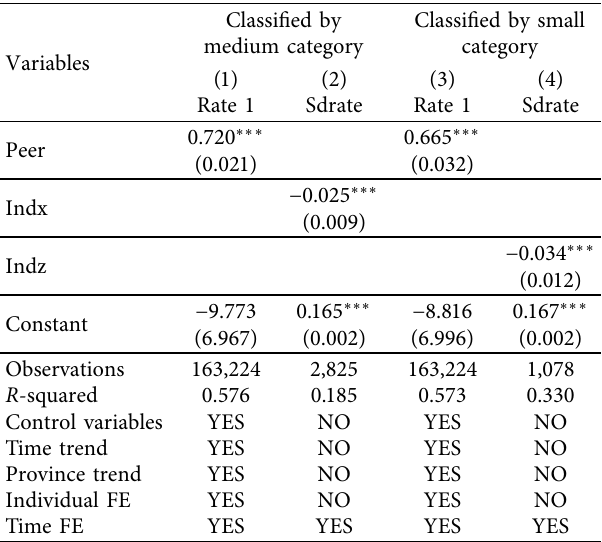
Table 8: Peer effect